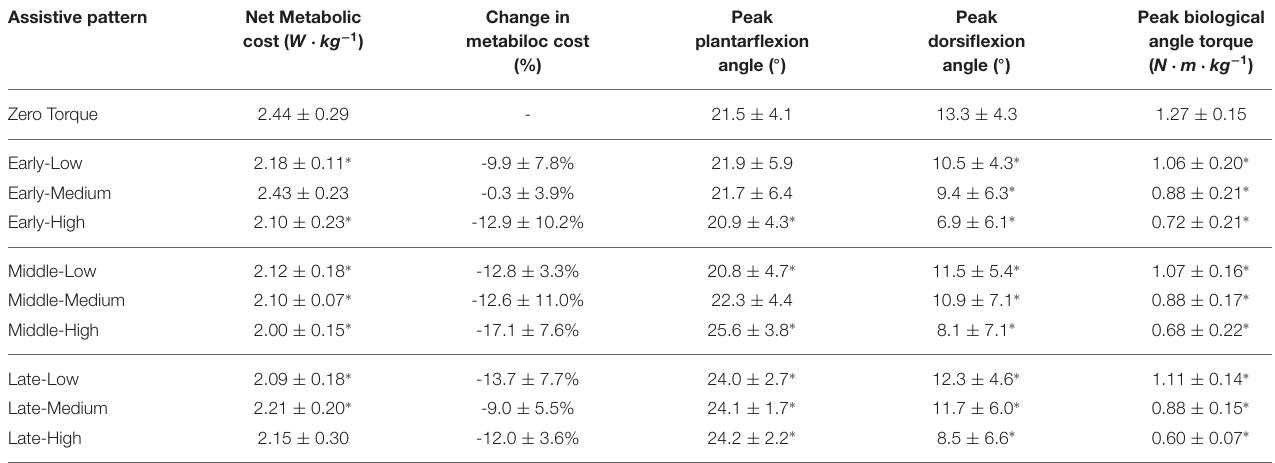
TABLE 2 | Energetics and biomechanics results during walking with different ankle exoskeleton assistances. Assistive